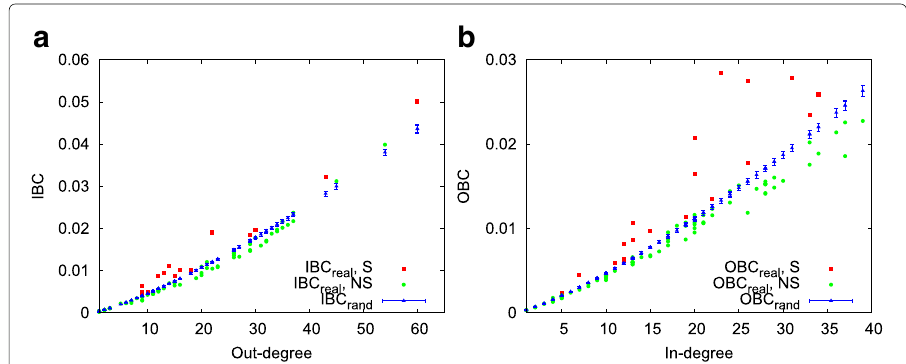
Fig. 6 Input betweenness centrality (IBC) a and Output betweenness centrality (OBC) b of each node in a food web of Florida bay are plotted against its out-degree and in-degree, respectively. The blue triangles are the average value over 1000 randomized networks with degree-preservation. The error bars represent the standard deviation. The red squares represent nodes whose IBC or OBC are judged to be significantly higher than those of the corresponding nodes in degree-preserving random networks by the procedure describe in the main text. The green points are the other non-significant nodes